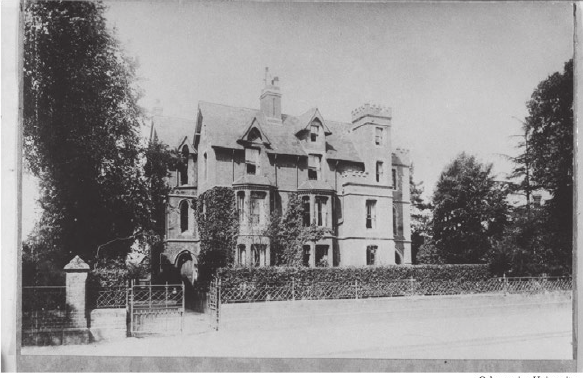
Figure 5 (ku-6017). Kuroda’s boarding house on 139 Woodstock Road, Oxford (Ochanomizu University History Museum. Repro- duced with